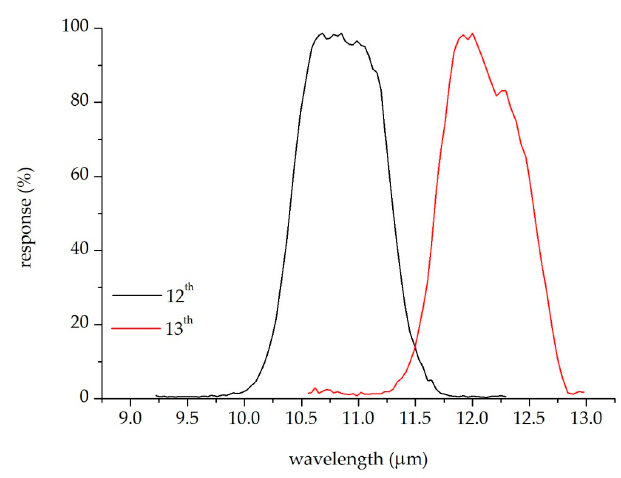
Figure 3 . Spectral response functions of AGRI 12th and 13th channels.